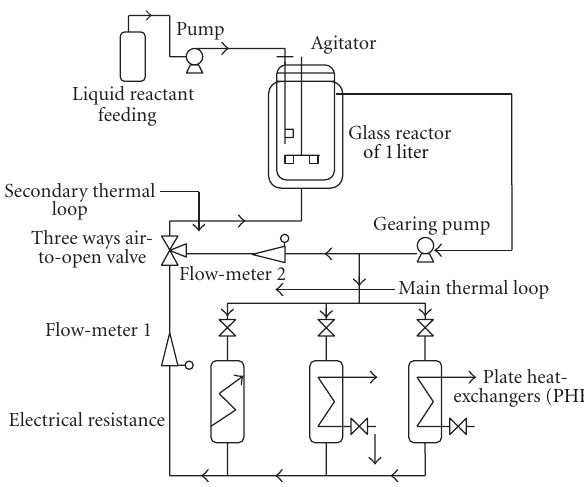
Figure 1: Schematic of the